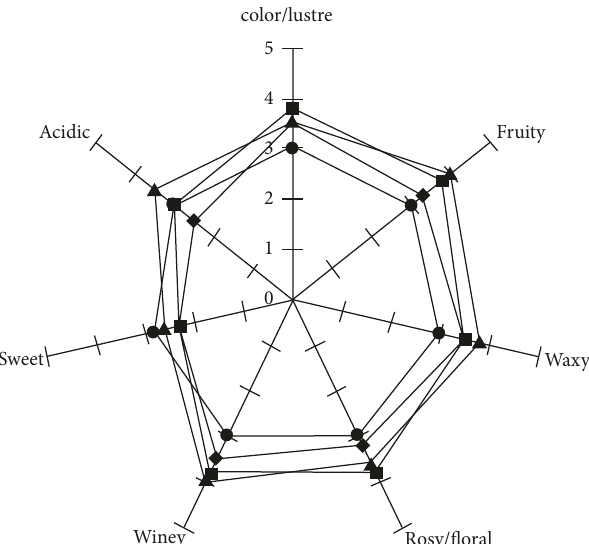
Figure 1: Aroma profile of hawthorn wines. Wine from the extracted juice with pectase ( e ); wine from the extracted juice without pectase ( ⧫ ); wine from nonextracted pulpy juice with pectase ( 󳵳 ); wine from nonextracted pulpy juice without pectase ( ◼